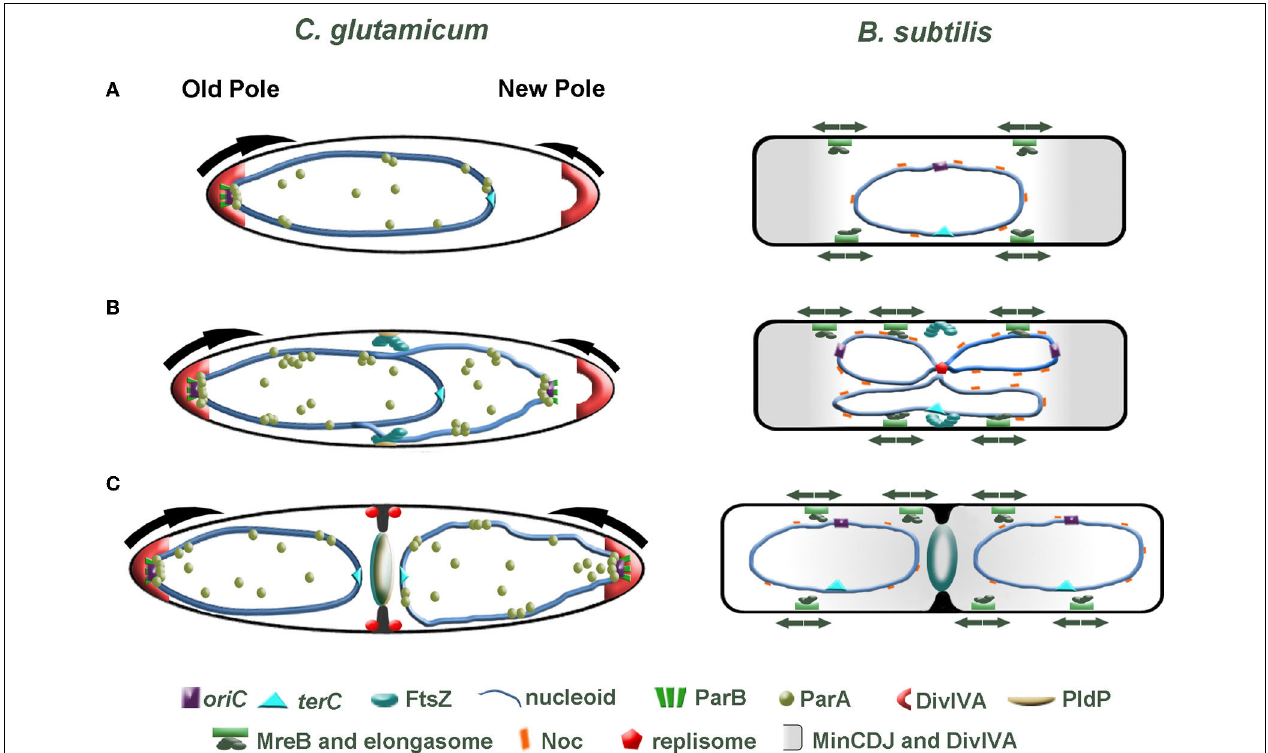
FIGURE 3 | Comparison of cell division in C. glutamicum and B. subtilis . (A) Directly after cell division, one cell pole contains a ParB-bound origin that is tethered at the old cell pole through interaction with the polar growth determinant DivIVA. At this stage of the cell cycle, we speculate that polar growth is asymmetric with the pole lacking a tethered origin (young pole) growing slower than origin bound pole (arrows). In B. subtilis , the post-divisional cell contains a centrally located nucleoid with the oriC and terC also found positioned at the midcell. (B) Initiation of chromosome replication gives rise to duplication of the oriC . In C. glutamicum , the newly duplicated oriC is bound by ParB, then ParA is recruited and the oriC is segregated to the opposite cell pole. FtsZ assembles into a Z-ring prior to complete segregation of the chromosome. The Z-ring does not always assemble precisely at midcell. The orphan ParA-like protein, PldP localizes to the division site, where it might function to spatially regulate cell division. In